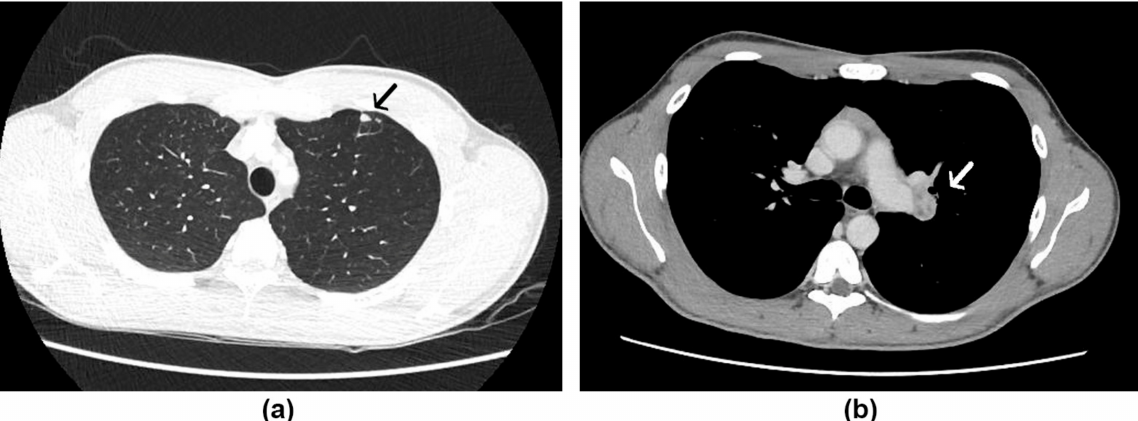
Figure 1. Chest tomography of case 1: ( a ) Nodular opacities on the periphery of the anterior segment of the upper left lobe (black arrow), ( b ) mediastinal lymph nodes (white